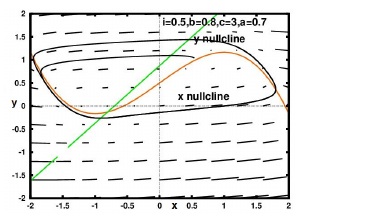
Figure 3. Phase plane, nullclines, and vec- tor field for the BVP model for I(t) = 0, a = 0.8 , b = 0.7 & c = 3